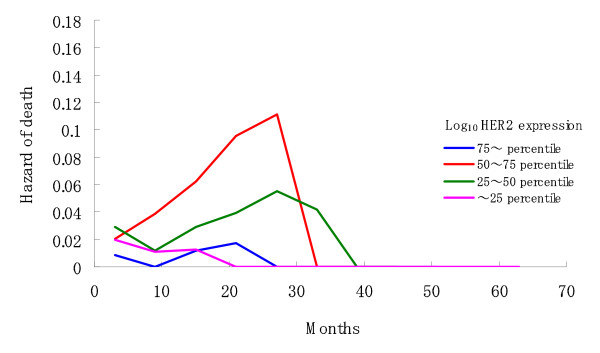
Hazard function plots with six-month interval by HER2 expression subgroup.